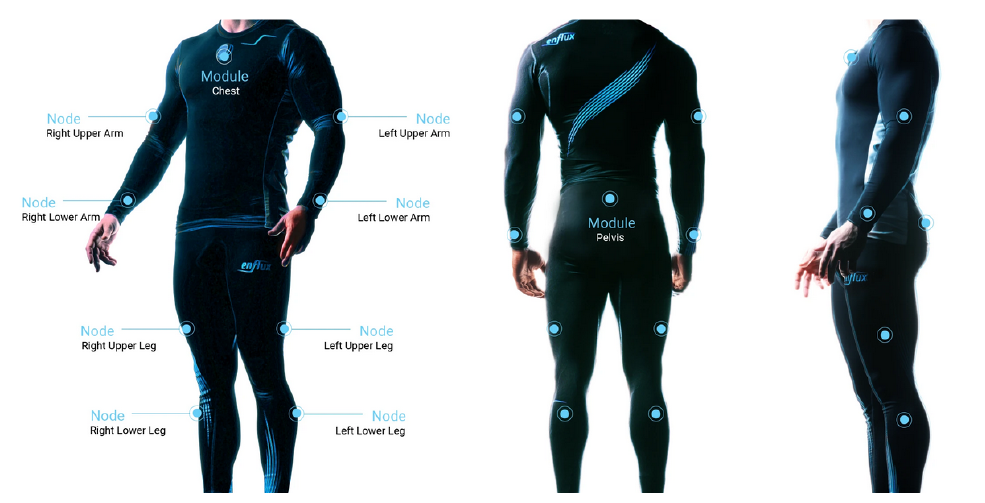
Figure 2. Monitoring suit sensors